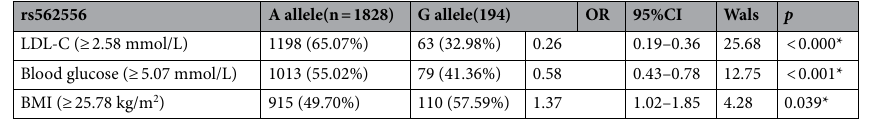
Table 8. Univariate logistic regression analysis of rs562556 genotypes for cardiovascular risk factors. OR odds ratio, CI confidence interval, LDL-C low density lipoprotein-cholesterol, BMI body mass index. * p -values <